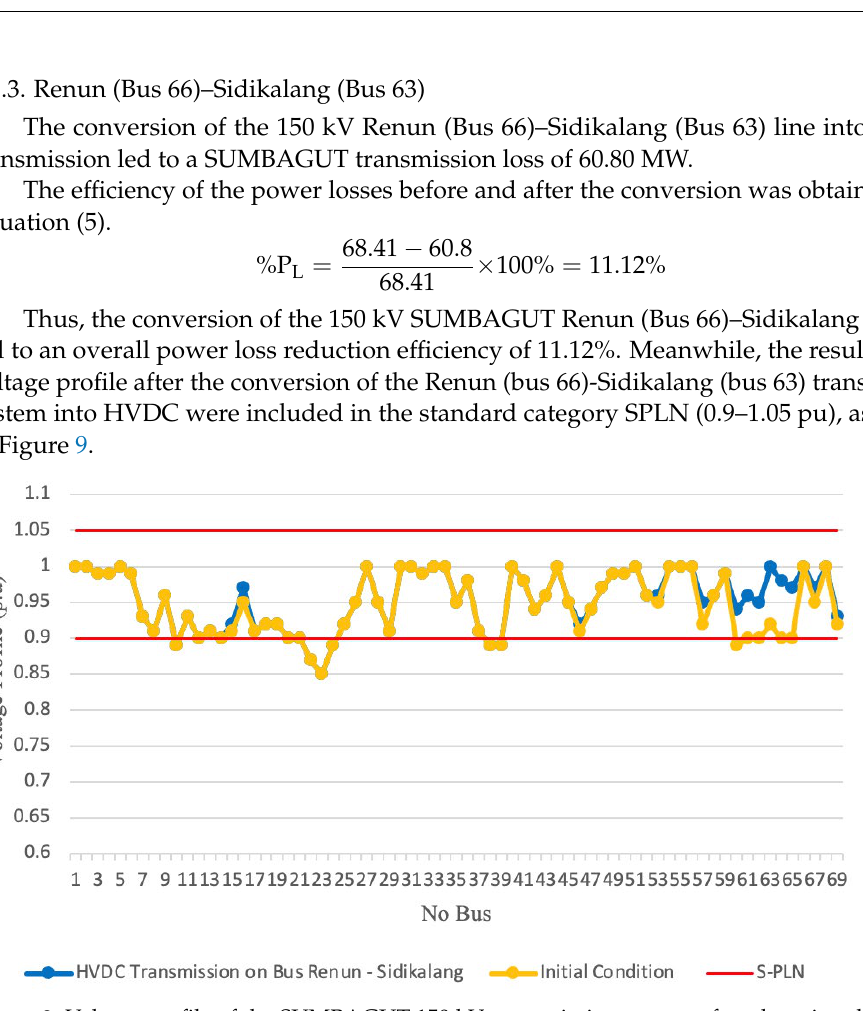
Figure 8. Voltage profile of the SUMBAGUT 150 kV transmission system after changing the Paya